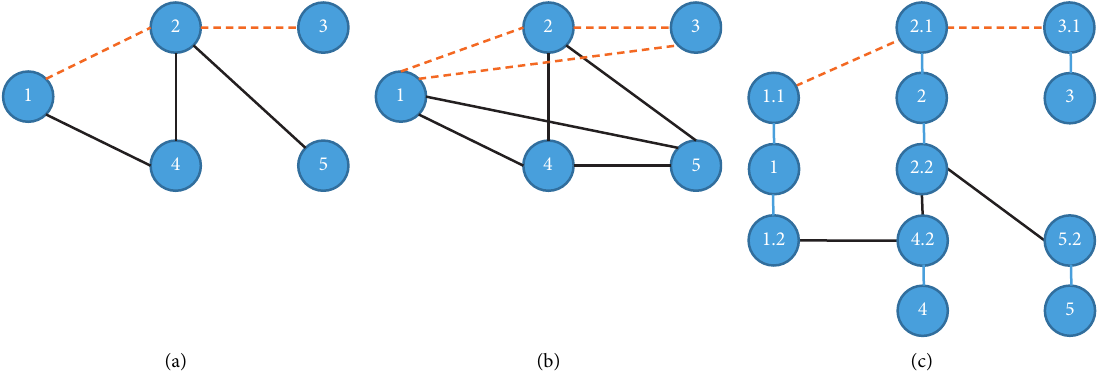
Figure 3: (a) Toy network with 2 bus lines; (b) Direct Link Network representation. (c) Change and Go